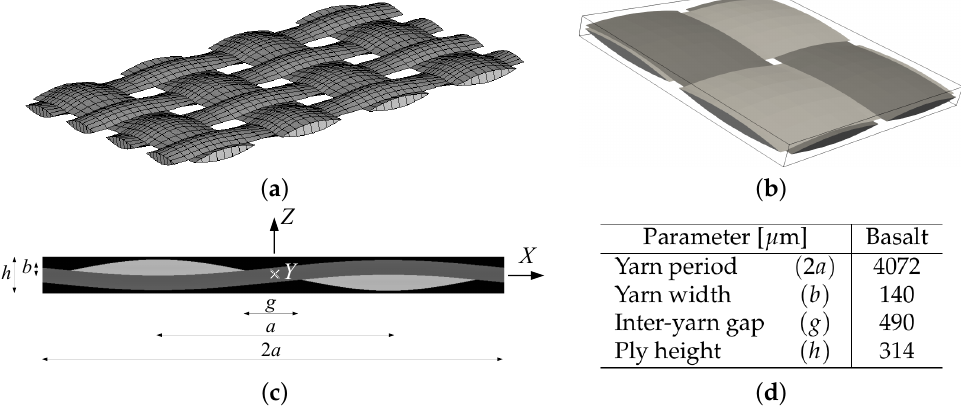
Figure 4. Example of periodic unit cell of a single ply textile composite: ( a ) plain weave arrangement of yarns, ( b ) plain weave PUC, ( c , d ) basic geometrical data. Table 3. Indentation results of basalt fibers.